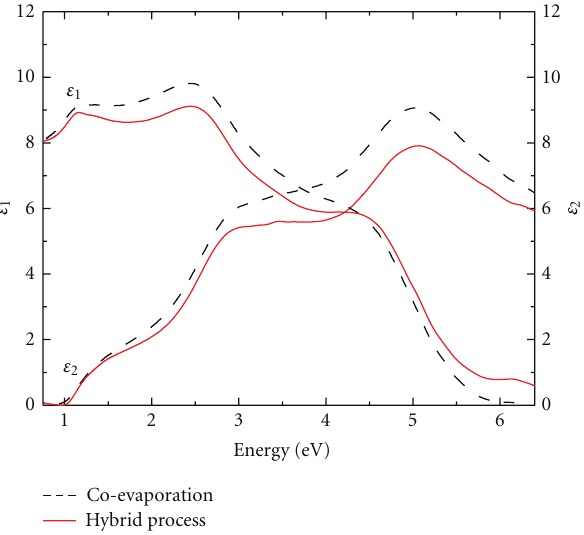
Figure 2: Optical dielectric functions for Cu(In,Ga)Se 2 films deposited by the hybrid process (solid line) and coevaporation process (dotted line).